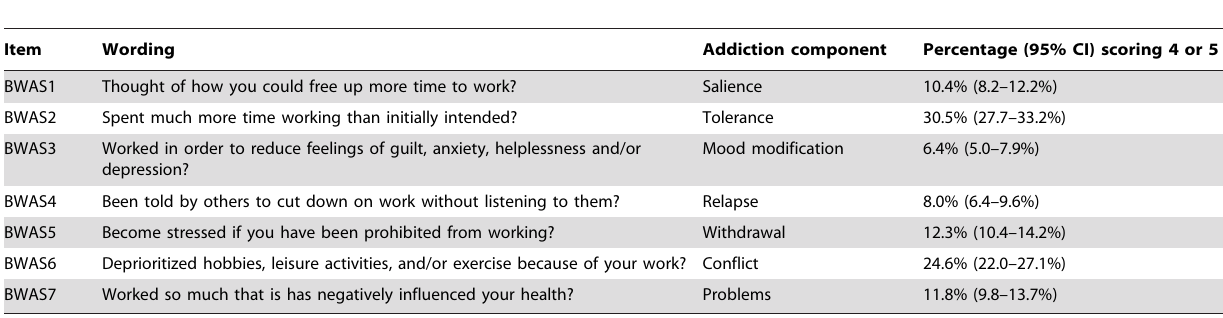
Table 3. Percentage and 95% confidence interval (95% CI) of the respondents who endorsed (scoring 4 or 5) on the items of the Bergen Work Addiction Scale (BWAS; Andreassen, Griffiths, et al., 2012) (N